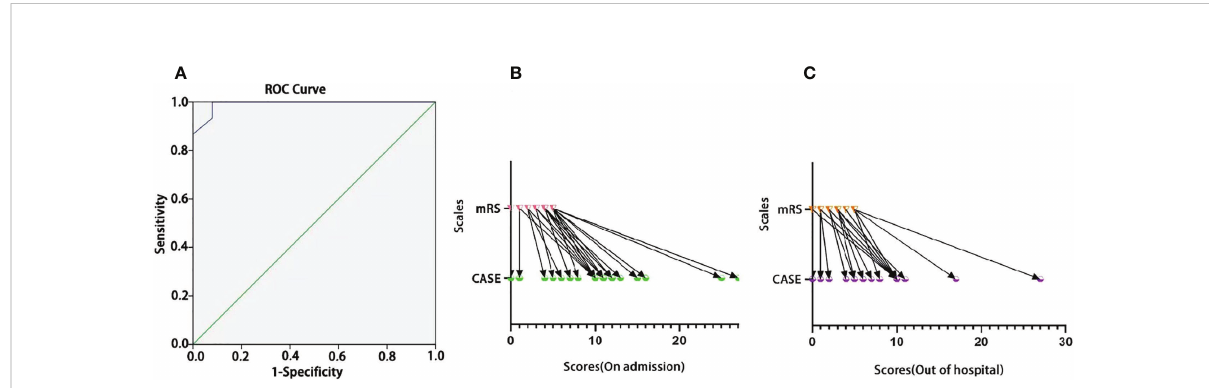
FIGURE 1 The ROC curve of the CASE total score as a predictor of disease severity in terms of the need for intensive care. (A) The one-to-one corresponding scores of the same individual on the CASE and the mRS [ (B) for admission; (C) for out of hospital].